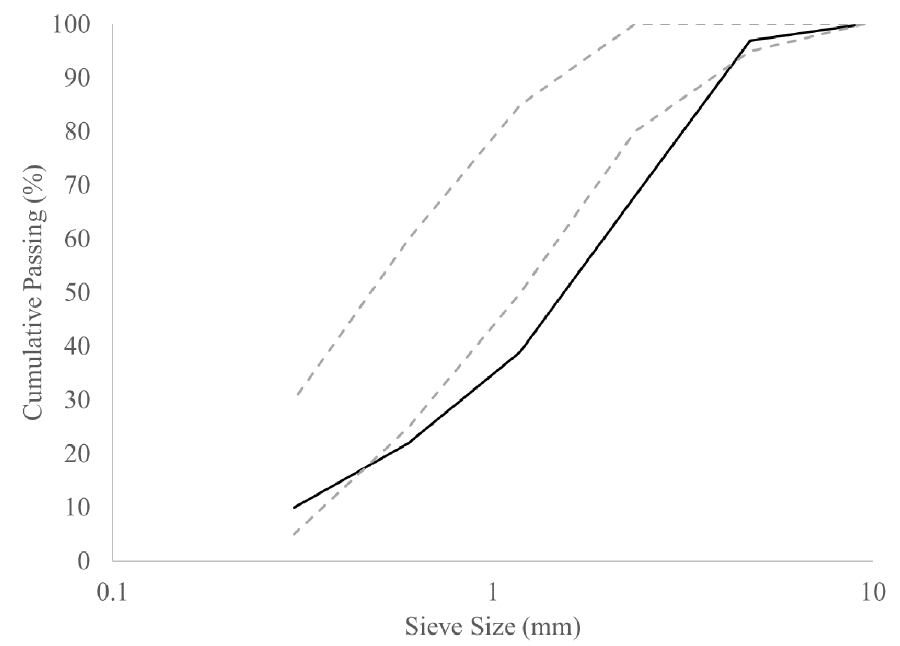
Figure 1. Grain size distribution of crushed sand (full line), accompanied by the ASTM C33 gradation limits (dashed lines). Table 1. SSD, oven dry densities and absorption values of the crushed sand, for each of the sieved fractions, indicated by their maximum particle size.